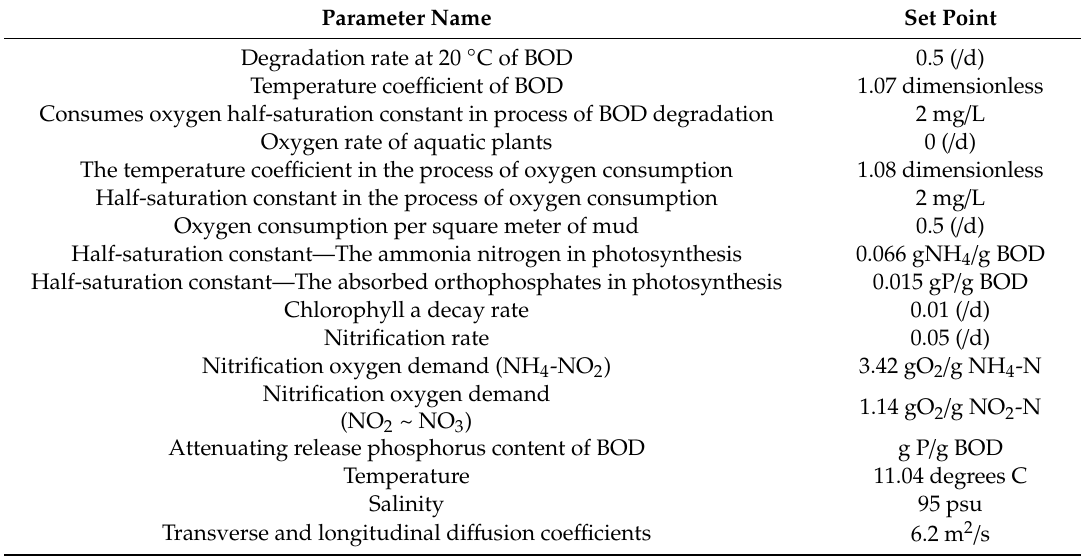
Table 4. Some parameters settings of the water quality